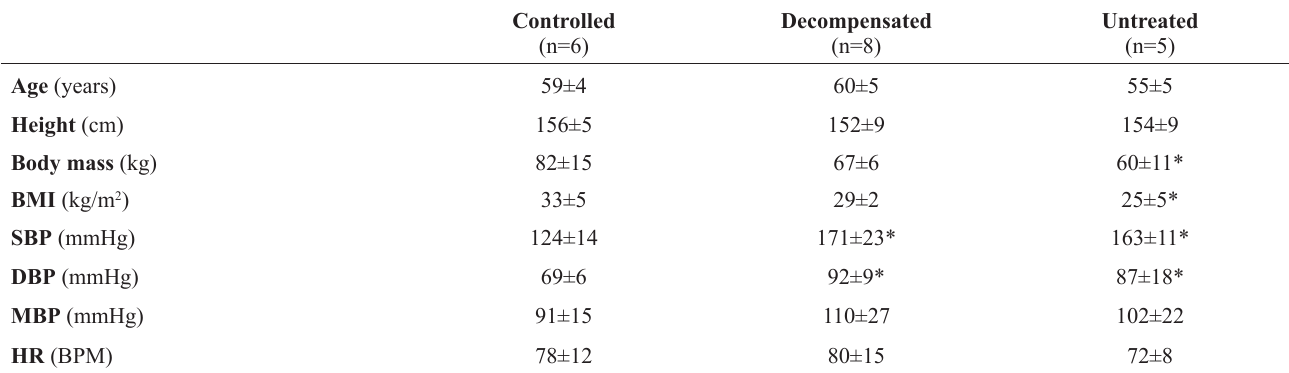
Table 2 - Sample characteristics.